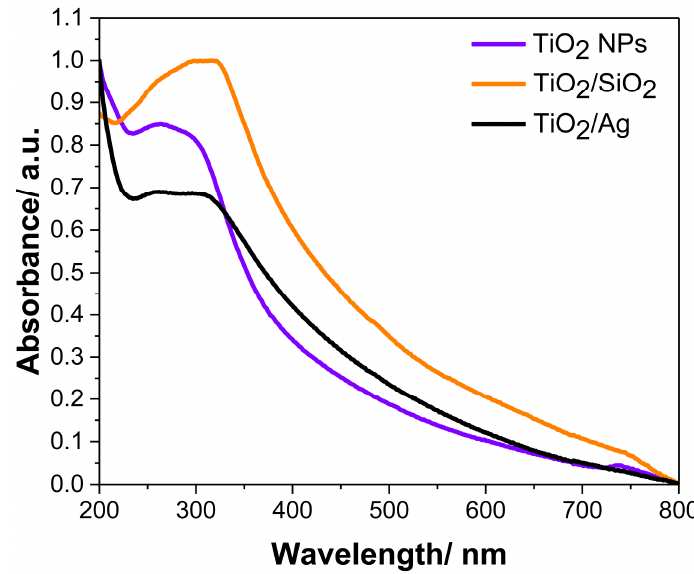
Molecules 2023 , 28 , x FOR PEER REVIEW Figure 5. Absorption spectra of TiO 2 NPs, TiO 2 /SiO 2 , and TiO 2 /Ag. Figure 5. Absorption spectra of TiO 2 NPs, TiO 2 /SiO 2 , and TiO 2 /Ag.